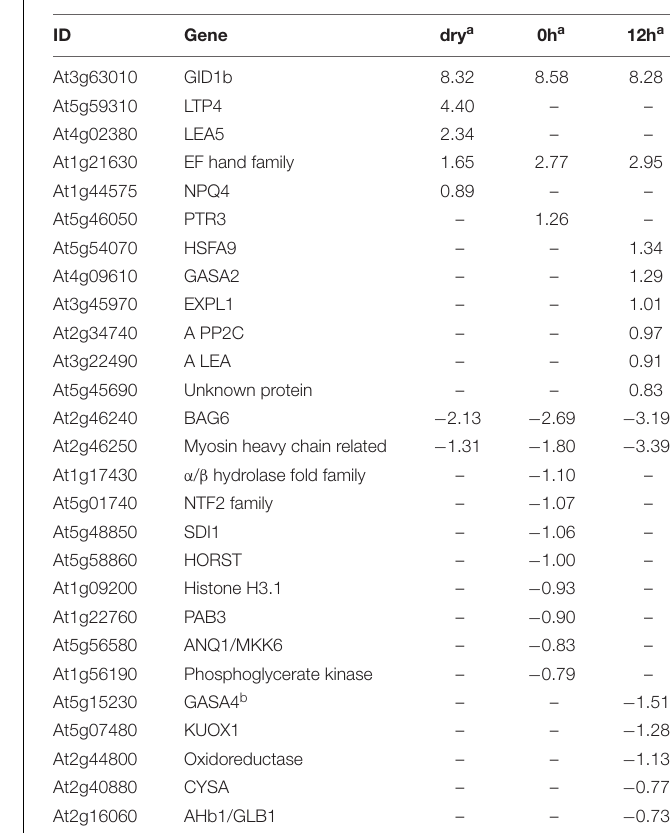
TABLE 1 | Complete table of sly1-2 GID1b-OE vs. sly1-2 (D) differentially regulated genes across all three imbibition